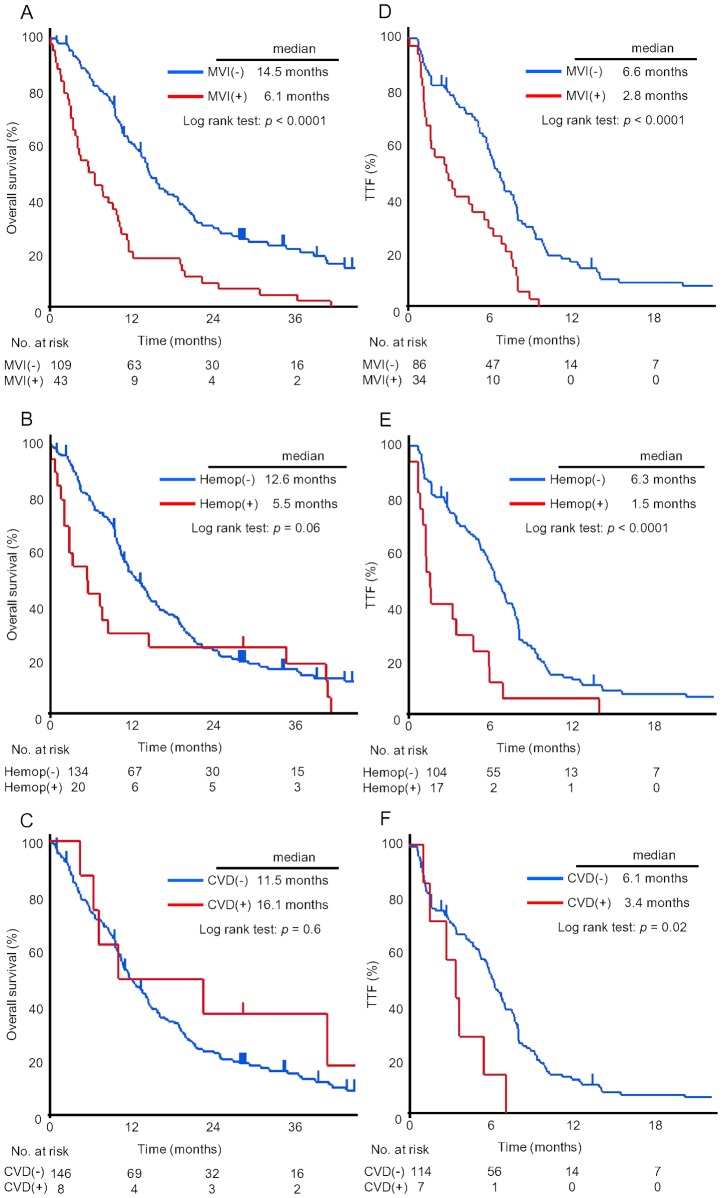
Overall survival and time to treatment failure by each condition defining the eligibility for bevacizumab.Kaplan-Meier curves for overall survival by MVI (A), history of hemoptysis (B) and CVD (C) and time to treatment failure by MVI (D), history of hemoptysis (E) and CVD (F). CVD, cardiovascular disease; Hemop, history of hemoptysis; MVI, major blood vessel invasion; TTF, time to treatment failure.